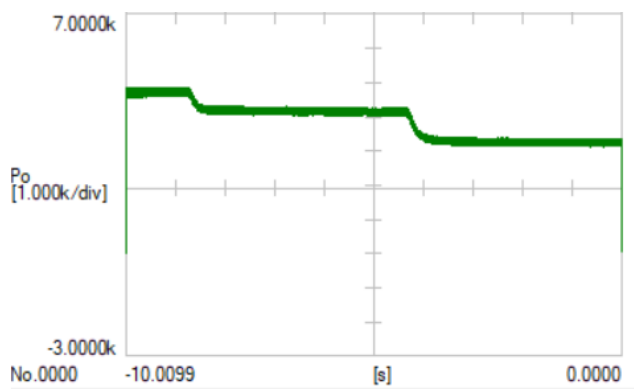
Figure 16. Active power delivered to the